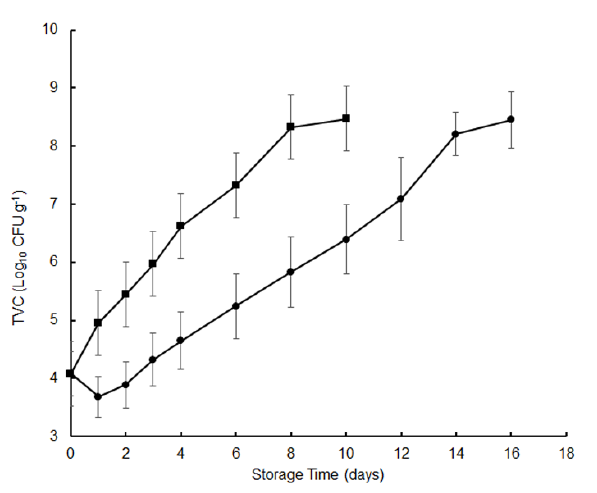
Figure 1. Changes in the total viable count (TVC) of crisp grass carp fillets during storage at 4 °C. CFU, Colony-Forming Units. ▪, distilled water treatments; ●, tea polyphenol treatments. CFU, Colony-Forming Units. (cid:4) , distilled water treatments; • , tea polyphenol